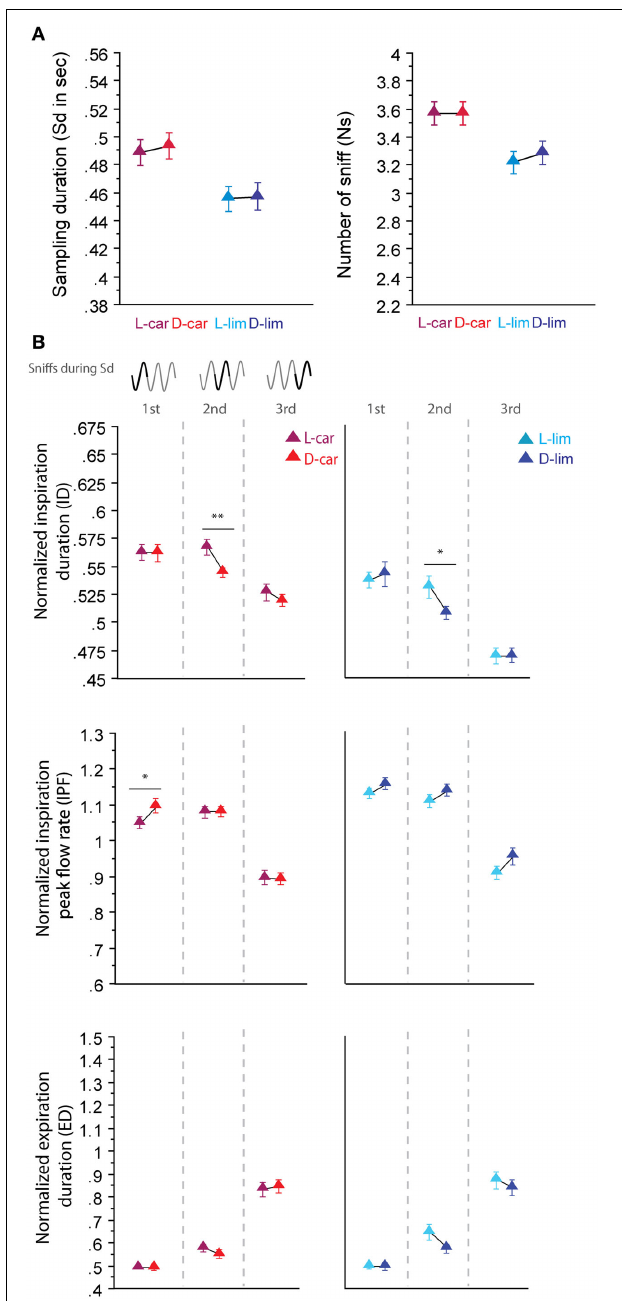
FIGURE 3 | Enantiomers are sniffed similarly. (A) Global sampling parameters (mean ± s.e.m.), Sd (left) and Ns (right), for each odorant in each enantiomer odor pair: L-car (magenta)/D-car (red) n = 195; L-lim (cyan)/D-lim (dark blue) n = 211. (B) Modulation of sniff parameters in the first, second, and third cycles for (left to right) L-car/D-car and L-lim/D-lim. From top to bottom: mean ( ± s.e.m.) normalized ID, IPF, and ED. Same colors as in (A) . The number of trials for each odorant and cycle in L-car/D-car pair is: n cycle 1 = 195, n cycle 2 = 188, and n cycle 3 = 175 and in L-lim/D-lim pair is: n cycle 1 = 211, n cycle 2 = 201, and n cycle 3 = 162. Data were analyzed using a paired t -test; ∗ p < 0 . 05; and ∗∗ p < 0 . 01.